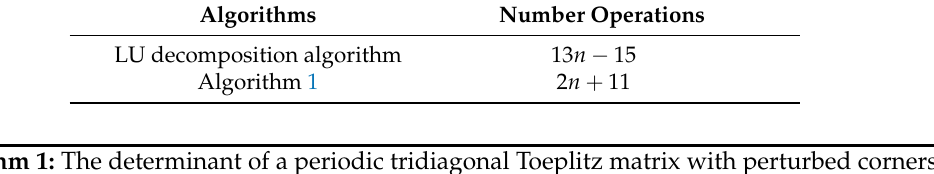
Algorithm 1: The determinant of a periodic tridiagonal Toeplitz matrix with perturbed corners of type 1